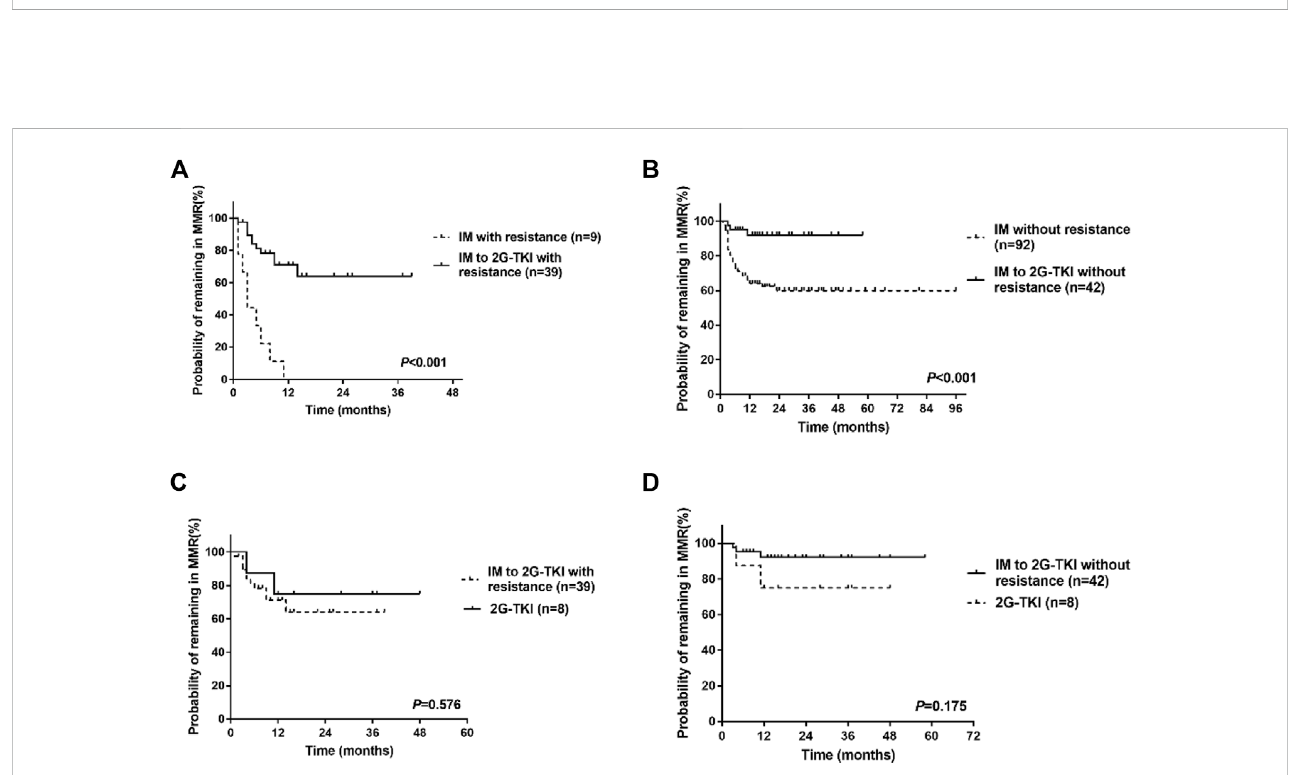
FIGURE 4 Treatment-free remission (TFR) in patients after tyrosine kinase inhibitor (TKI) therapy. (A) TFR in patients with imatinib resistance. (B) TFR in patients without resistance. (C) TFR in patients who switched to 2G-TKI for imatinib resistance or patients with 2G-TKI. (D) TFR in patients who switched to 2G-TKI therapy without imatinib resistance or patients with 2G-TKI. IM, imatinib; 2G-TKI = second-generation